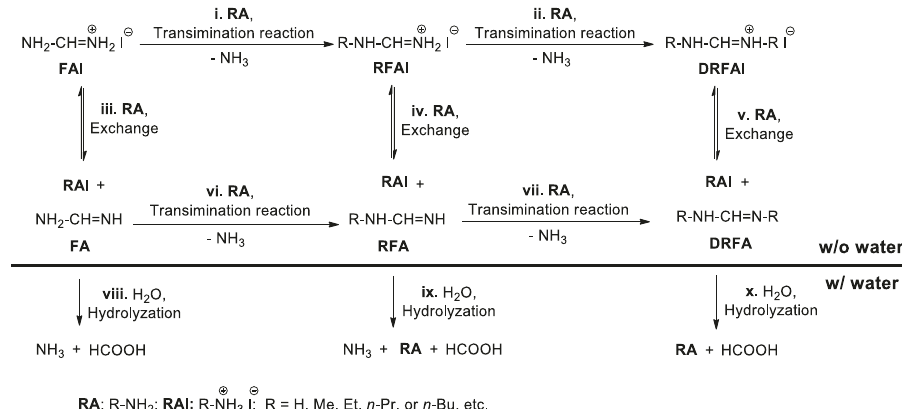
Fig.1|ChemicalreactionsrelatedtoFAI. ThetransiminationreactionsandtheionexchangereactionsbetweenFAIandRA 0 molecules(RreferstoH,Me,Et, n -Pr,or n -Bu etc.), and the hydrolysis reactions of FA 0 , RFA 0 , and DRFA 0